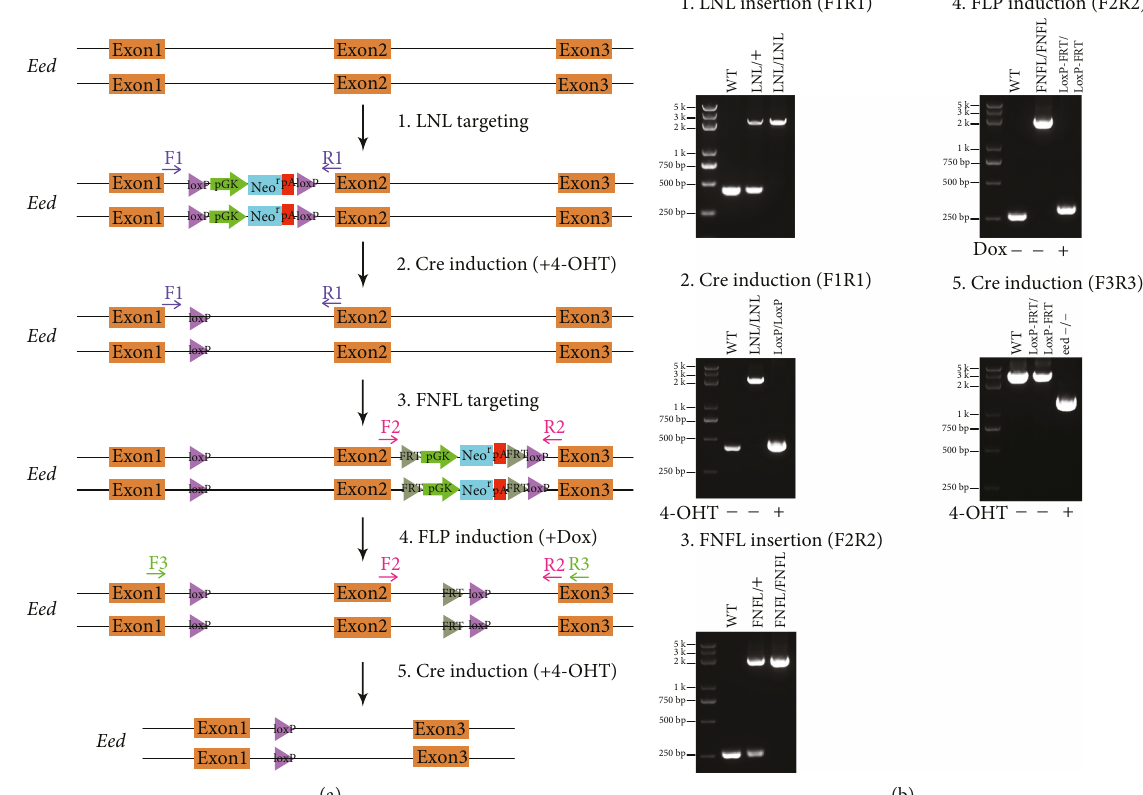
Figure 2: Genotyping of Eed conditional knockout generated by a two-step targeting strategy. (a) Schematics of sequential targeting LNL and FNFL cassettes to the Eed gene in two steps. (b) The genotyping results of sequential targeting LNL and FNFL cassettes to the Eed gene. In clones with biallelic insertion of LNL cassettes, a 2.29kb DNA fragment was ampli fi ed without detecting the 431bp wild-type amplicon with primers F1 and R1 (b1). When the neo r cassette was depleted upon 4-OHT treatment, we detected a 497 bp PCR amplicon with primers F1 and R1, which was slightly larger than the 431bp wild-type allele due to the remaining LoxP site (b2). For FNFL homozygous insertion, the PCR amplicon changed from the 263bp wild-type allele to the 2.16kb targeting allele using primers F2 and R2 (b3). Next, Dox-inducible FNFL depletion results in the 311 bp DNA fragment, which was slightly larger than the 263bp wild-type allele because of the remaining LoxP and FRT sites (b4). Finally, when the targeting clones were treated with 4-OHT, a 1.3kb PCR amplicon was ampli fi ed with primers F3 and R3 instead of detecting a 2.38kb DNA fragment (b5), indicating that the 2nd exon of Eed was